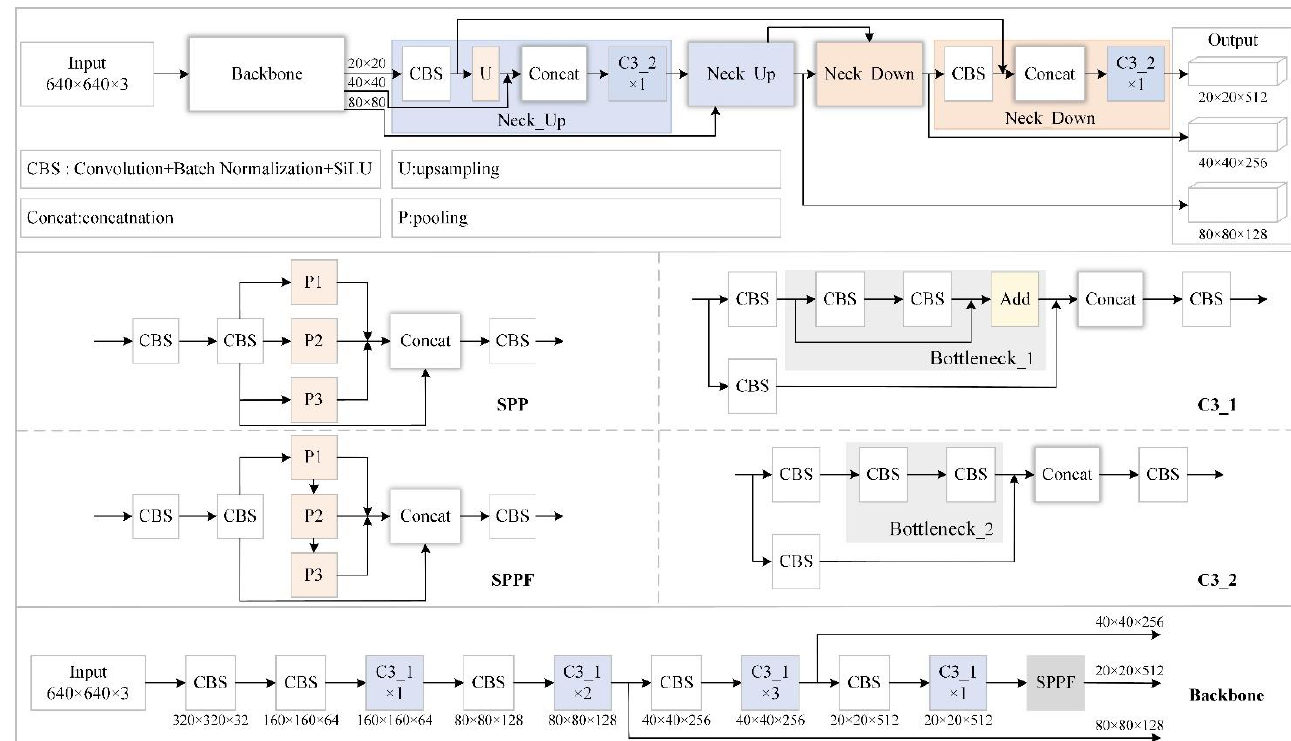
Figure 2. Structure of Yolov5s network.